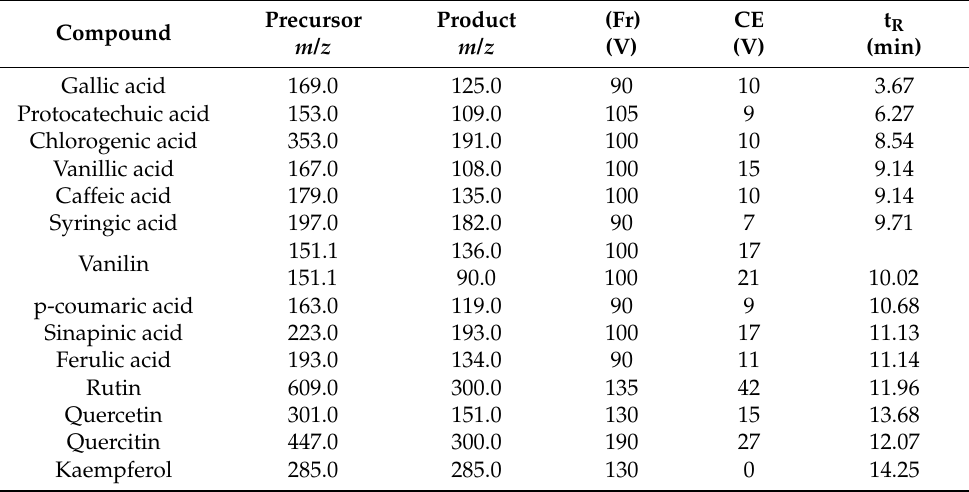
Table A1. Optimized dynamic MRM parameters.